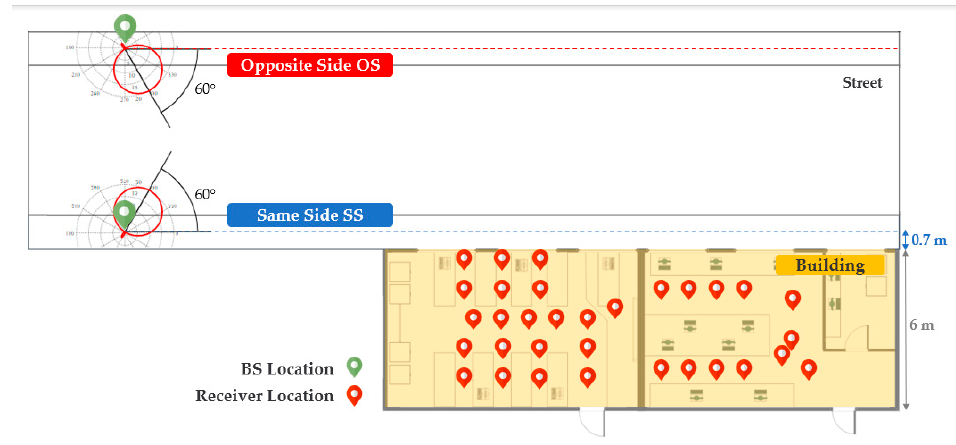
Figure 1. An example of the measurement layout. For the sampling process the receiver antenna was placed on a computer-controlled rotating arm involving measurements of 6° (or 0.105 rad) angular increments on circles of radius 0.4 m at each receiver placement. For each angular position 25 consecutive power samples were collected, in order to verify consistency and averaging, and to remove residual temporal fades, which did not fluctuate by more than ± 0.5 dB due to the narrowband static environment. Then, these consecutive samples were averaged to account for the first power sample value and to continue to the next angular position until 60 possible angular positions were completed in a 360° circle. Finally, 60 received signal power samples were collected at each receive location, as illustrated in Figure 2. Regarding receiver locations, a total of 308 and 108 sample locations were reported for the O2I NLOS USM and UDP scenarios, respectively.